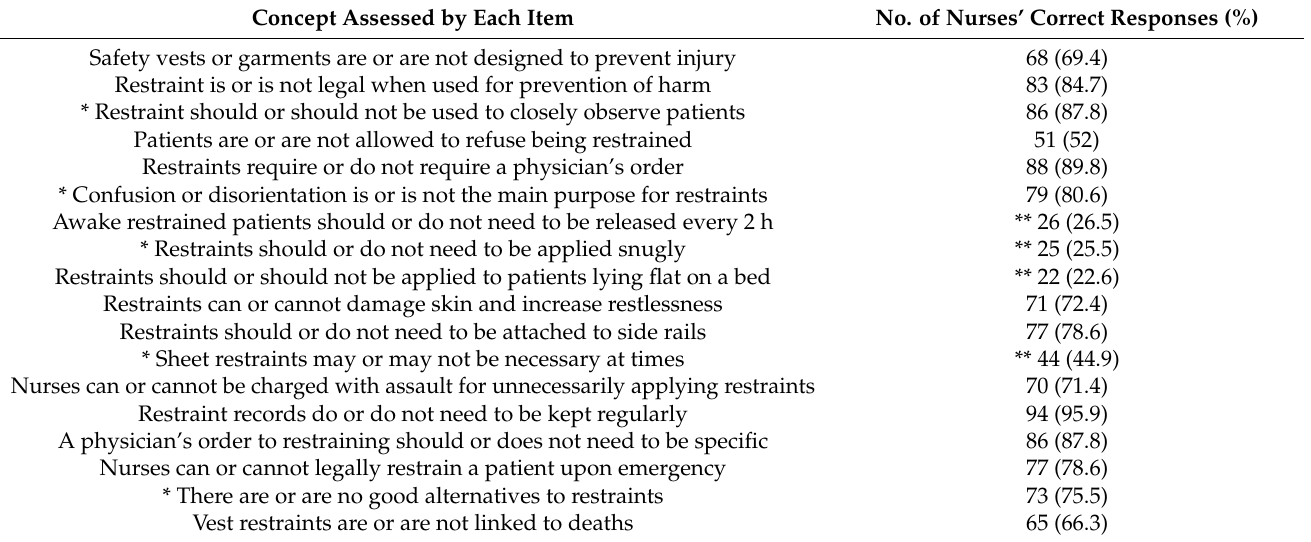
Table 2. Level of knowledge of restraints among psychiatric nurses ( n =